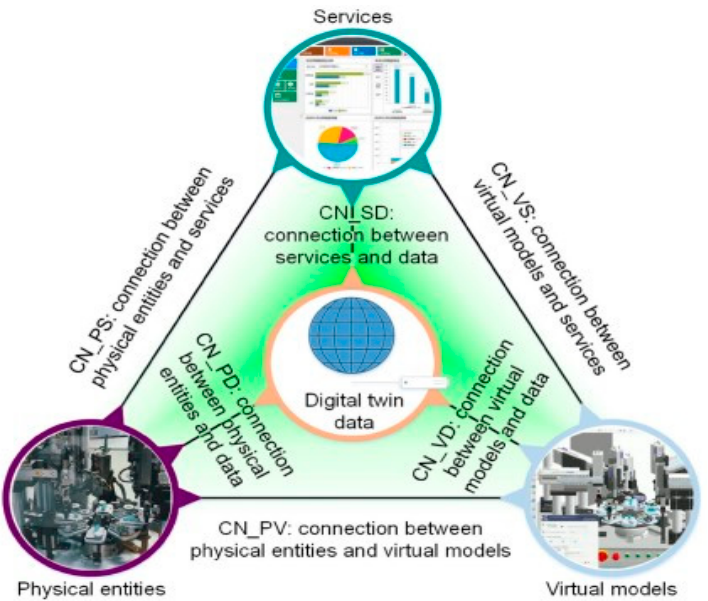
Figure 5. The working of the digital twin model [41].